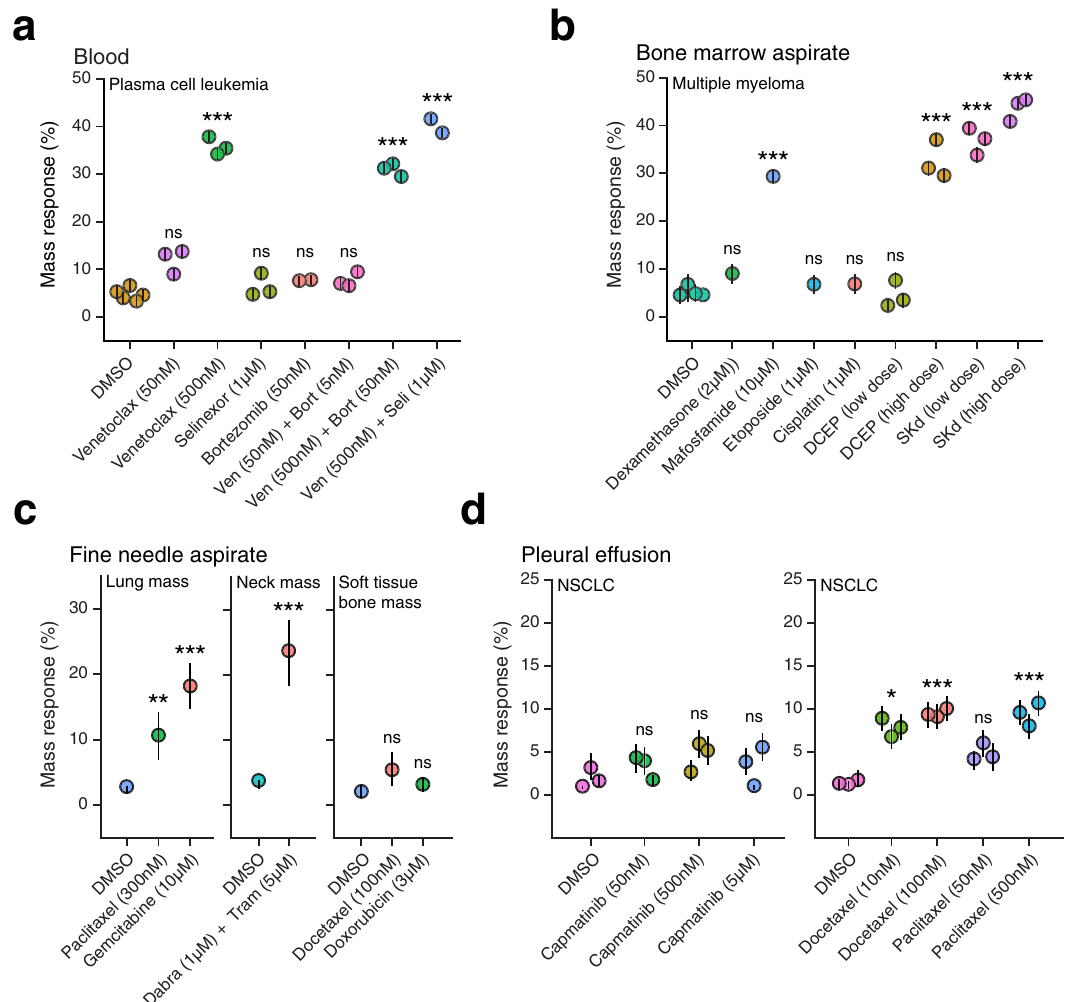
Fig. 7 Mass response assessment of drug sensitivity for various cancer specimen formats. Mass response measurements were collected for a plasma cell leukemia (PCL) cells isolated from a peripheral blood sample and treated for 15 h with the drugs listed, b multiple myeloma cells isolated from a bone marrow aspirate sample and treated for 15 h with the drugs listed, c cells isolated from fi ne-needle aspirate (FNA) samples collected from a lung mass, neck mass, and soft tissue bone mass in three different patients with non-small cell lung cancer, melanoma, and breast cancer, respectively, and treated for 20 h with the drugs listed, and d non-small cell lung cancer (NSCLC) cells isolated from a pleural effusion sample and treated for 20 h with the drugs listed. For all plots, each point represents the mass response measured in an individual instrument, with error bars corresponding to the 95% con fi dence interval for mass response de fi ned by 5000 random samples of 2500 cells. *** indicates p < 0.001, ** indicates p < 0.01, * indicates p < 0.05, ns indicates p >